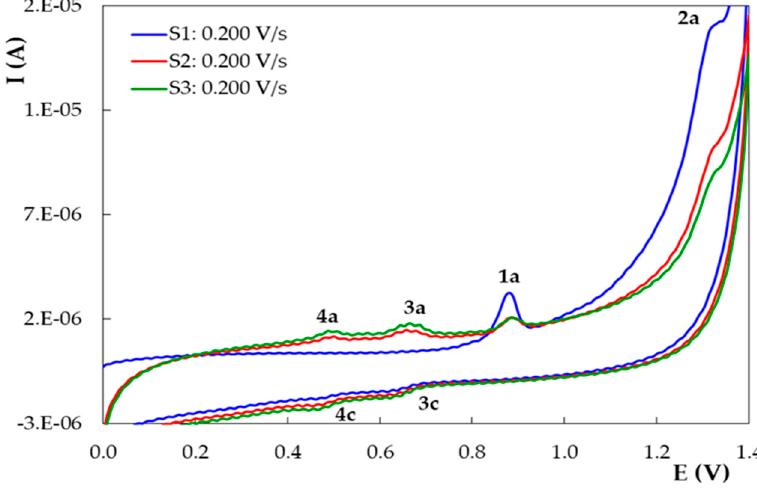
Figure 9. Successive repetitive cyclic voltammograms recorded on PGE_H for 1.00 × 10 − 5 mol/L DIO in in 0.10 mol/LH 2 SO 4 ; v = 0.200 V/s.